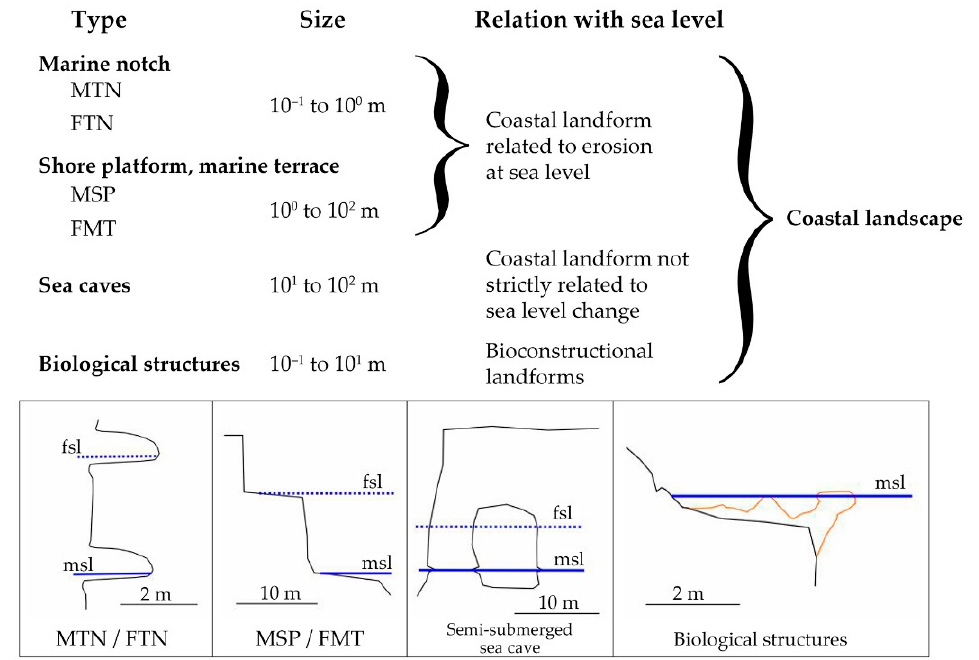
Figure 3. Coastal landforms studied in the Geoswim expeditions, with a graphical representation at the bottom of the figure. The solid line represents the current sea level, while the dotted line represents the fossil sea level.